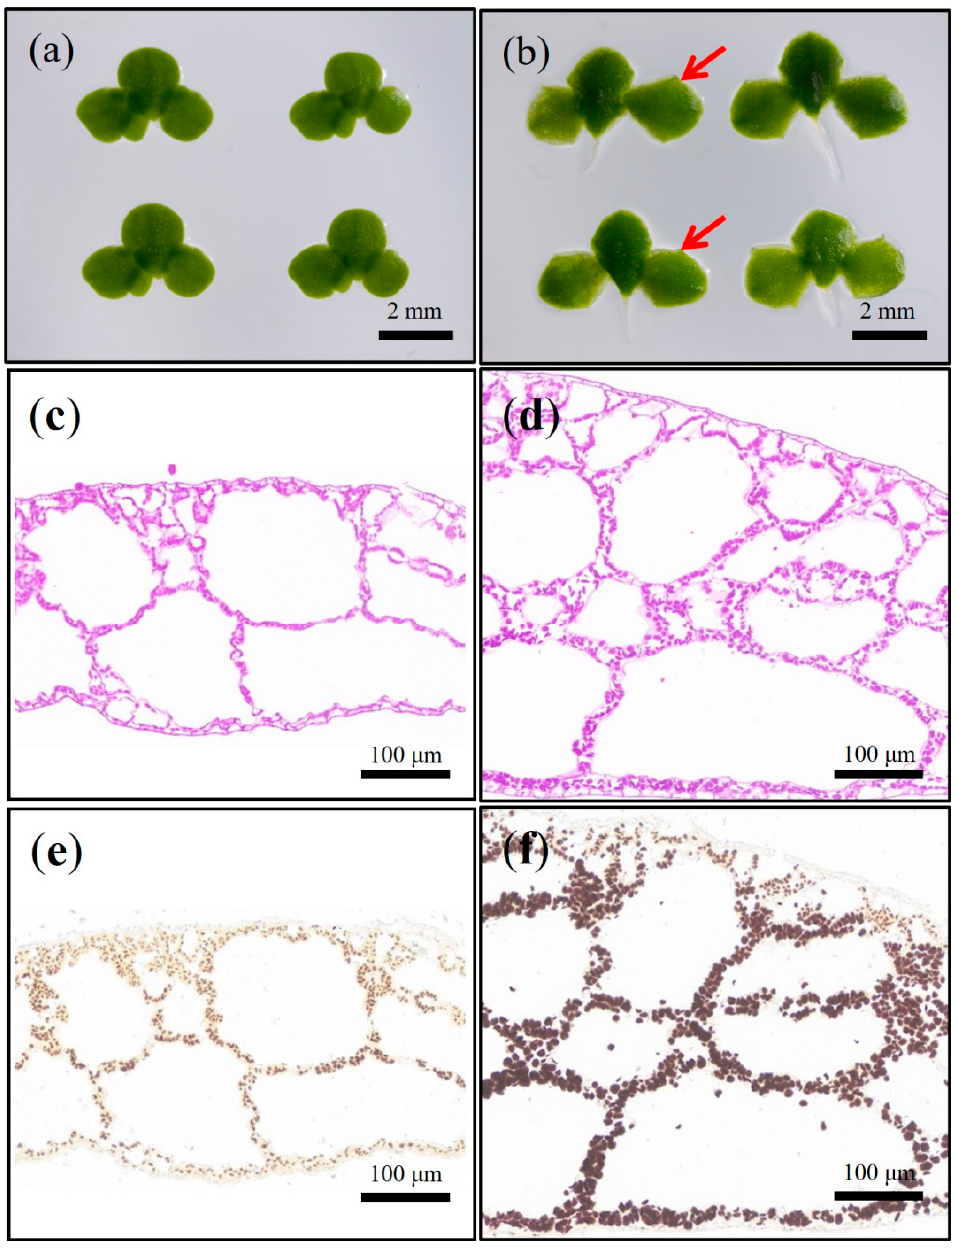
Figure 1. The analysis of phenotypic characteristics of the sub-1 mutant. ( a , b ): Frond shape difference between wild type and sub-1 mutant. ( c , d ): PAS staining of wild type and sub-1 mutant. ( e , f ): I 2 /KI staining of wild type and sub-1 mutant. Scale bars = 2 mm, 100 μ m.